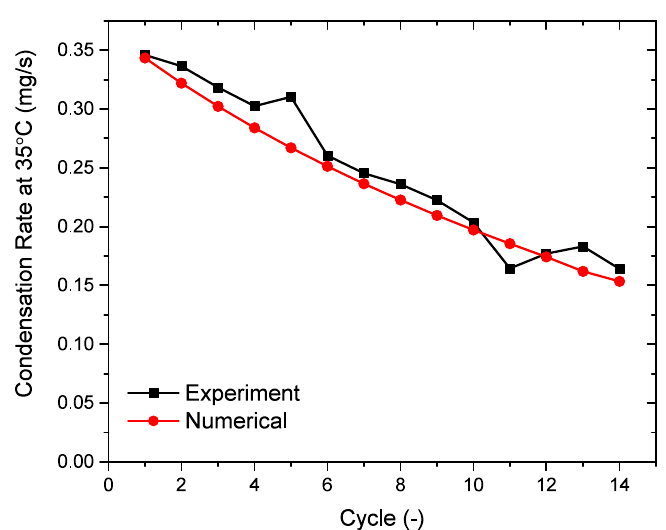
Figure 15. A comparison of the 8-hour average condensation rate between the experiment and the numerical calculations of experiment 3.